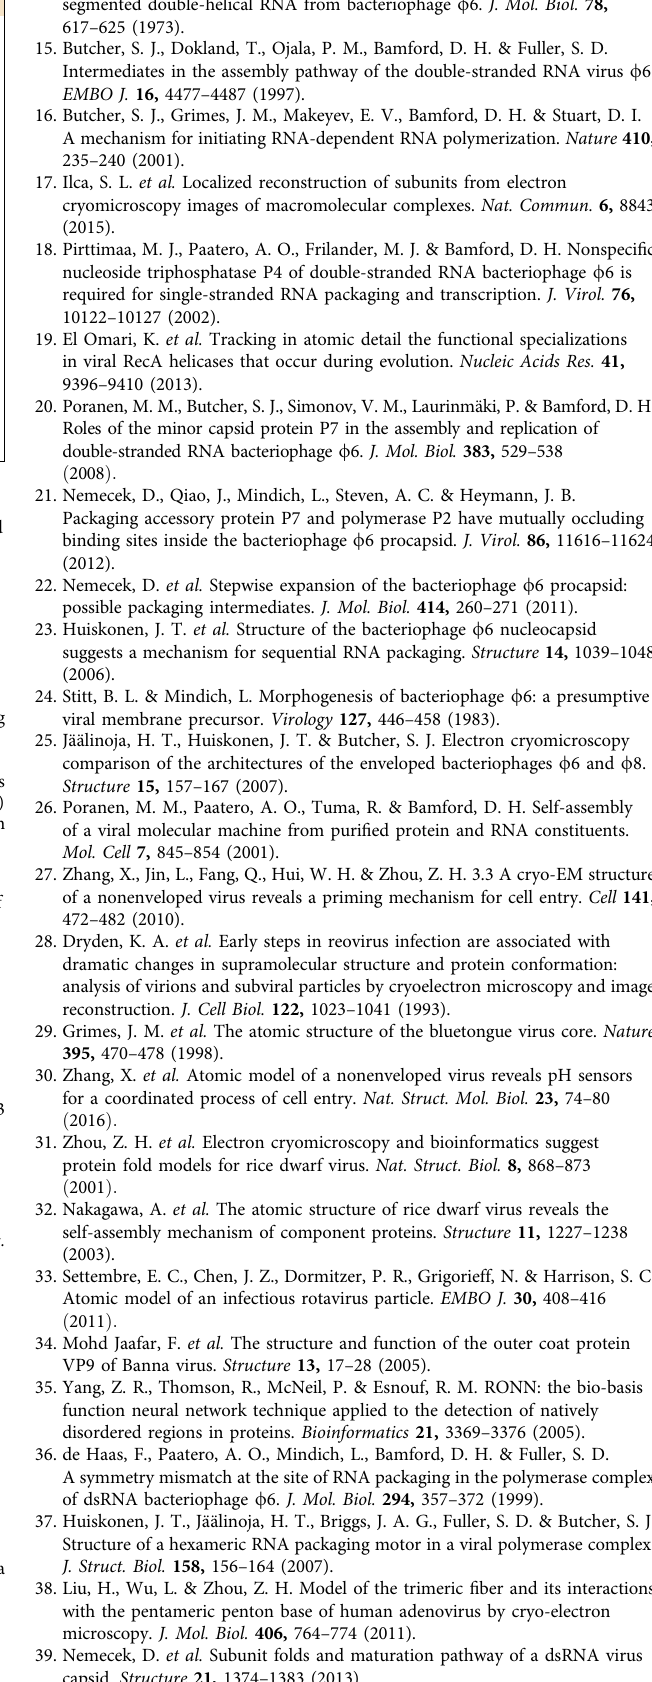
Table 3 | Atomic model refinement statistics.